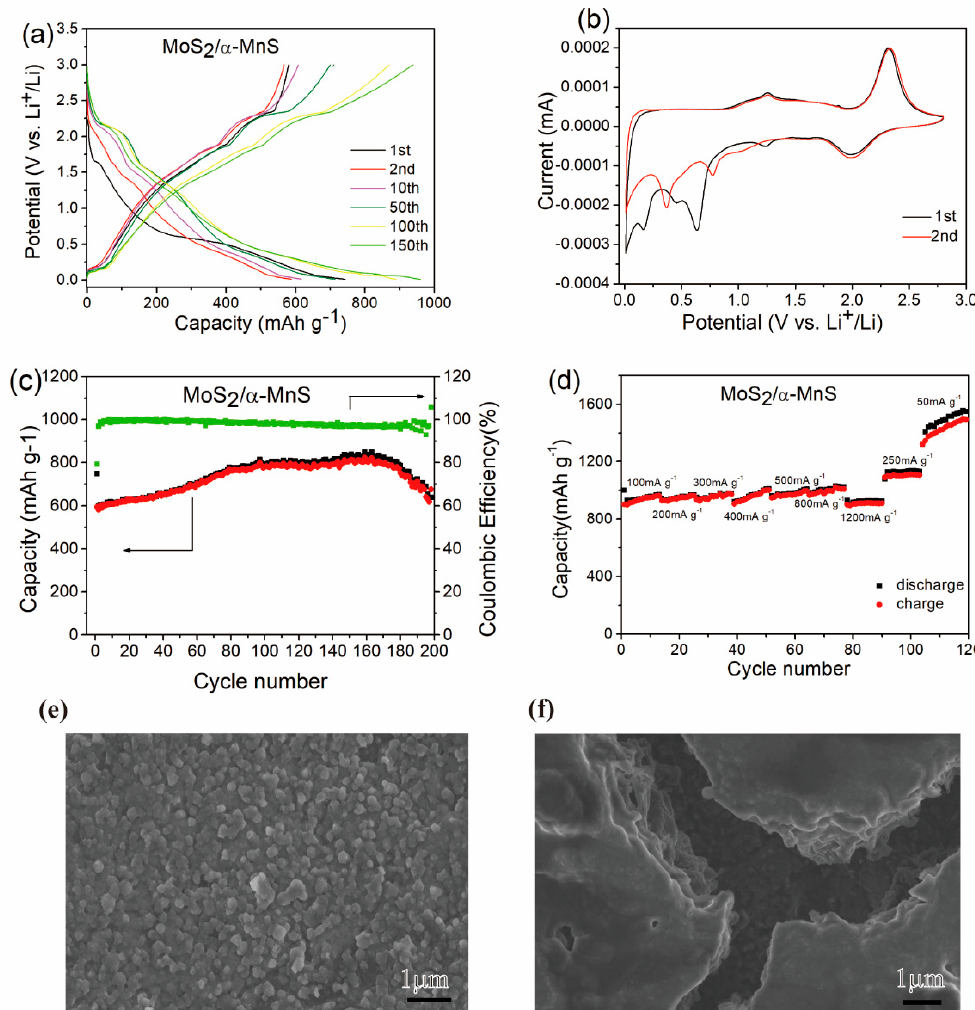
Figure 3. The galvanostatic measurements tested in the voltage range of 0.01–3.0 V for hierar- chical MoS 2 / α − MnS nanocomposites. ( a ) Discharge–charge profiles at 200 mA g − 1 . ( b ) CV curves tested in the voltage window of 0.01 − 2.8 V (versus Li + /Li) at a scan rate of 0.1 mV s − 1 . ( c ) Cycling − performance profiles at 300 mA g − 1 . ( d ) Rate − capability profiles at different rates. ( e , f ) SEM image electrode after 1 cycle and 150 cycles,